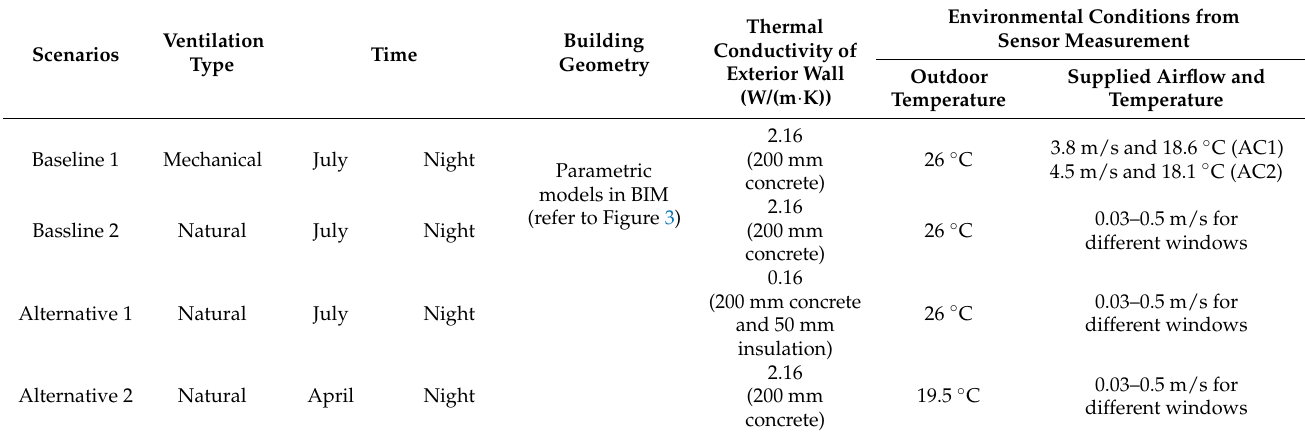
Figure 3. Parametric models from BIM and their boundary conditions for simulating ( a ) mechanical ventilation and ( b ) natural ventilation. ( b ) natural ventilation. Table 3. Summary of boundary conditions for CFD